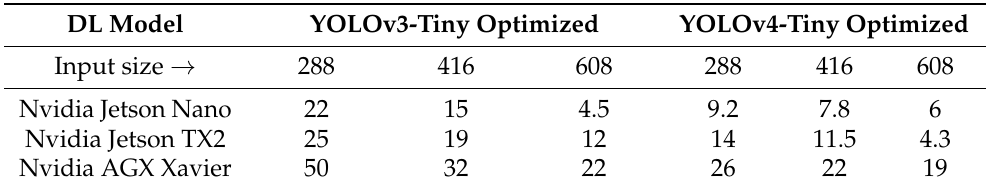
Table 3. FPS of YOLOv3-tiny and YOLOv4-tiny models on different scales of images during real-time detection with optimized weights.